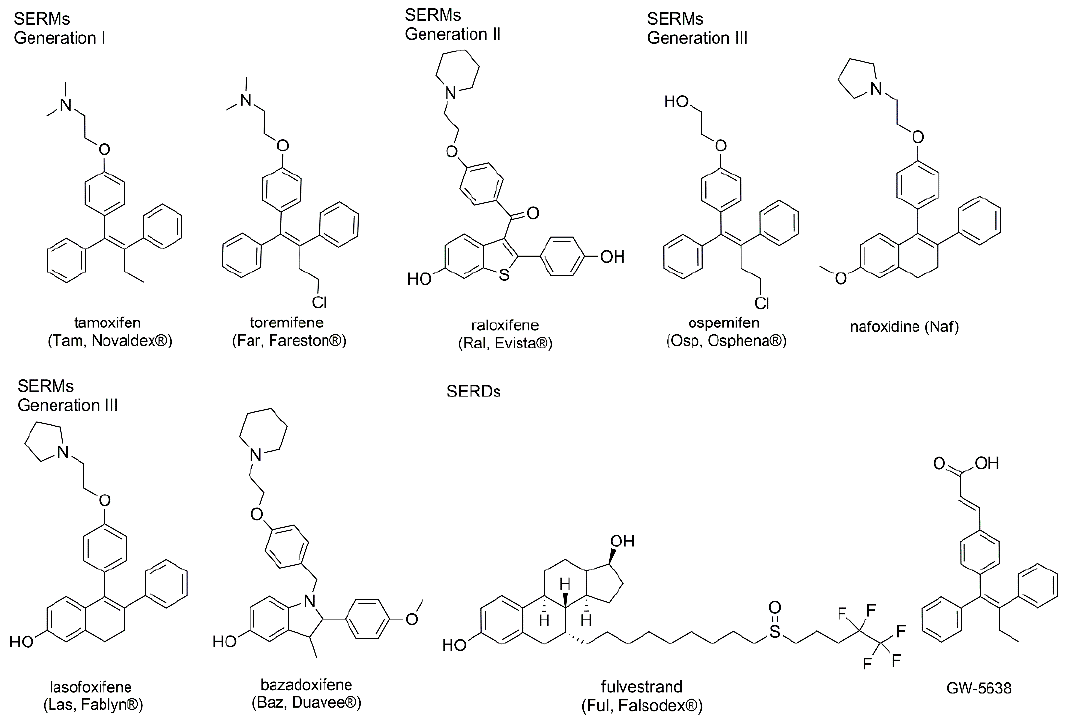
Figure 2. SERMs and SERDs as FDA-approved drugs and compounds in clinical trials for BC treat- ment.